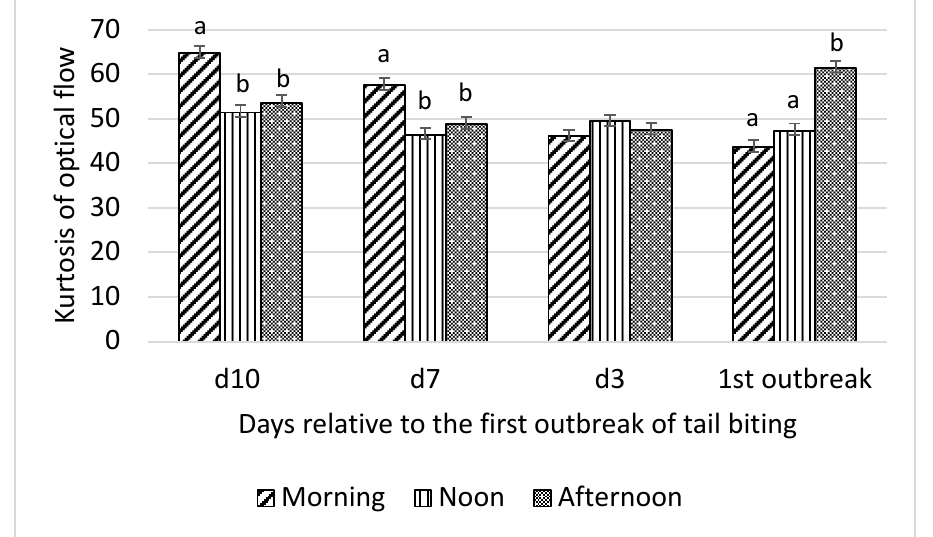
Figure 3. Interaction between day (10 d, 7 d, and 3 d before and during) relative to the first outbreak of tail biting and time of day (morning, noon, and afternoon) for skewness of optical flow; ab —within days means without a common superscript differ ( p < 0.01). Animals 2020 , 10 , 323